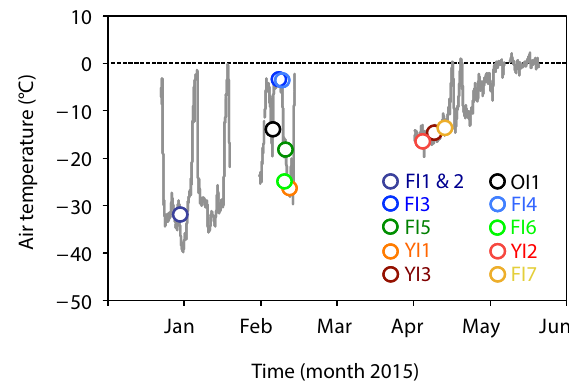
Figure 4. Time series of air temperature measured at the weather mast over the ice floe (10m height) (Hudson et al., 2015). Blank period indicates no data. Colored symbols indicate the date for the chamber flux measurements. The horizontal dashed line indicates air temperature of 0 ◦